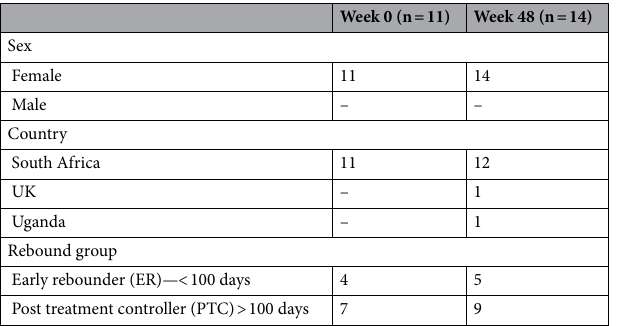
Table 1. Participant demographics. Number of participants with samples available for analysis at Week 0 and 48. Numbers of participants analysed by sex, country of origin and clinical rebound